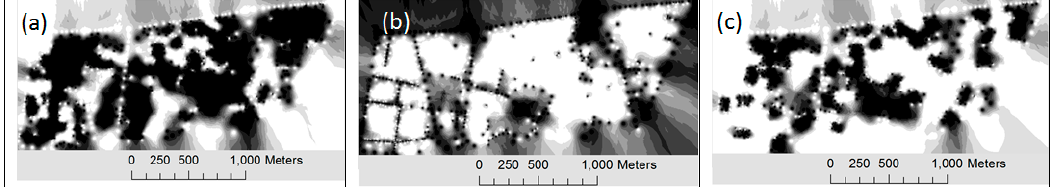
( b ) segregated path; and ( c ) hierarchical layouts.